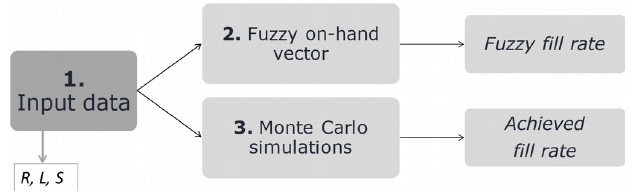
Figure 2. Experimental design